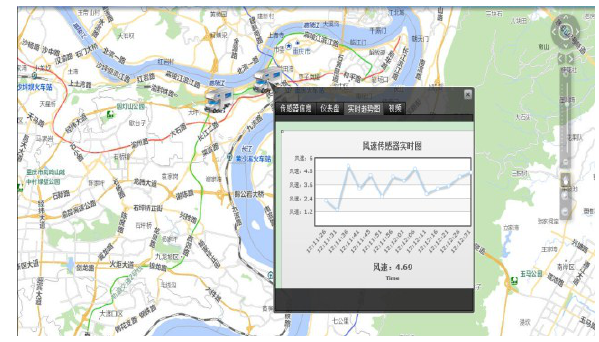
Figure 4. The application of Connected Car